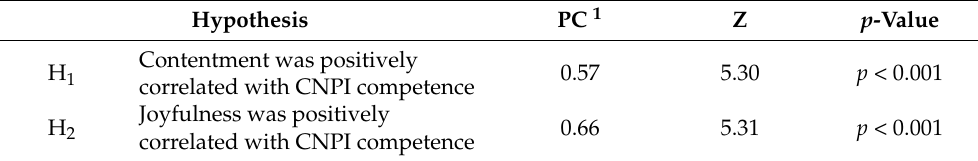
Table 3. Path coefficients of the structural model corresponded to hypotheses H 1 And H 2